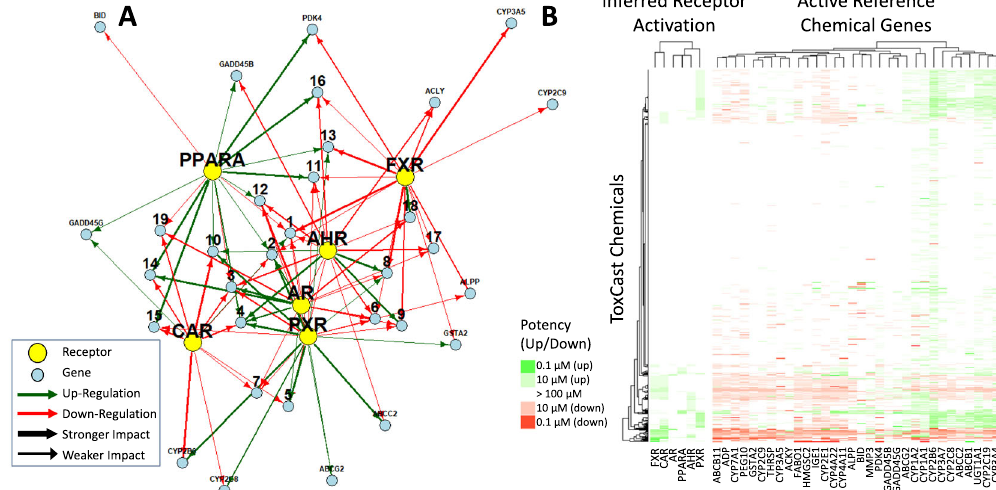
Fig. 6 Inferred signaling network and receptor activity. The network at the left (panel A ) represents the direction, magnitude of interaction, and cross-talk for the six receptors in HepaRG TM cultures as determined using the entire chemical library as a set of test perturbations. Genes regulated by three or more receptors are labeled numerically, as described in Table 2. The left-hand side of the heatmap (panel B ) indicates the relative potency inferred for the six receptors, while the right-hand side of Panel B presents the observed transcriptional response transcripts identi fi ed as part of the reference chemical signatures. The heatmap was created (with a function provided in the section “ R Code ” of the Supplementary Materials) using hierarchical clustering with complete linkage and Euclidean